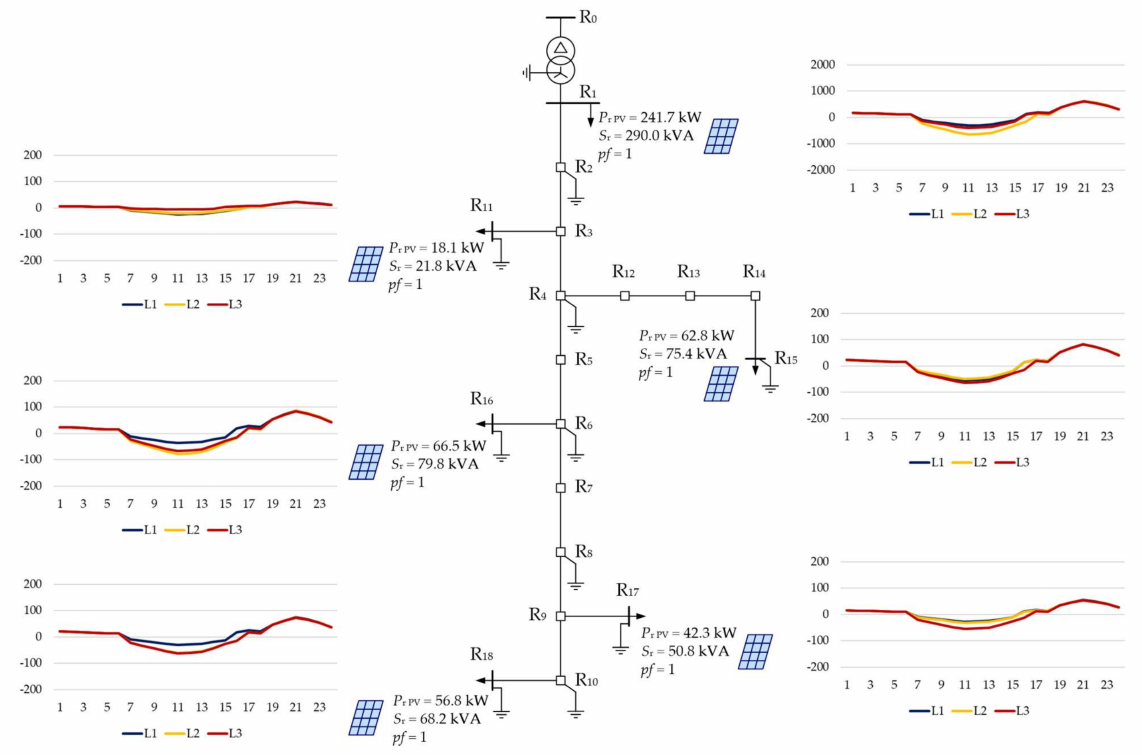
Figure A2. Daily simulation results for variant V4: phase currents